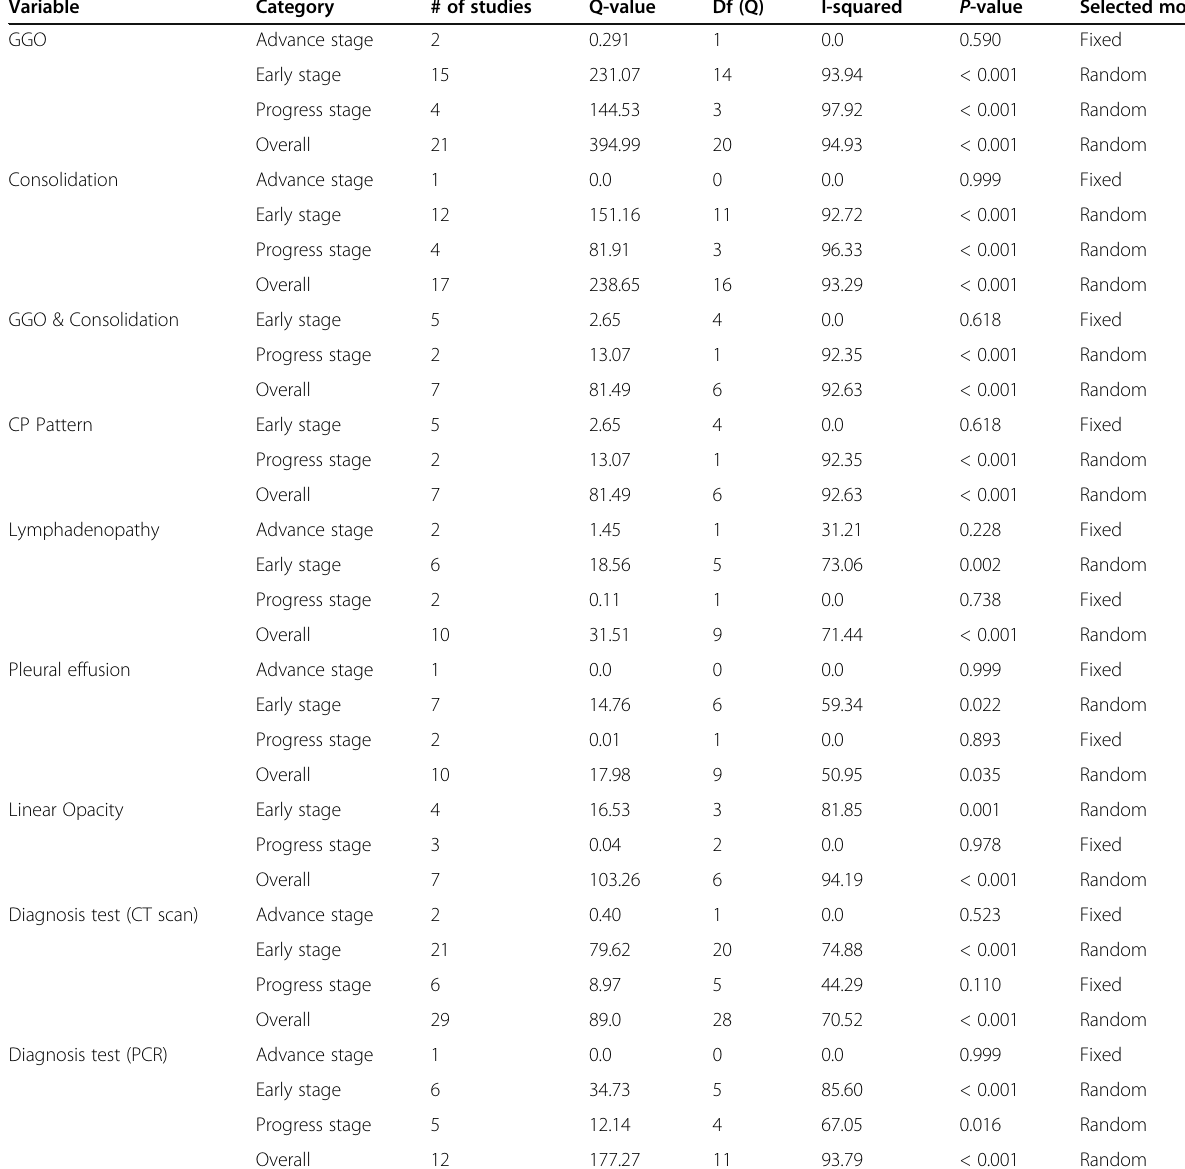
Table 2 Results of heterogeneity among included studies